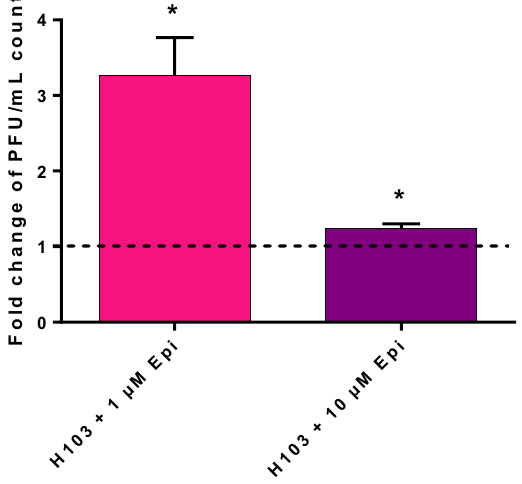
Figure 2. Effect of Epi on phage PO4 sensitivity. Phage PO4 sensitivity towards P. aeruginosa H103 was tested in presence of 1 and 10 µ M of Epi after 24 h. Plaque lysis were enumerated and expressed in PFU/mL, fold change is expressed for each condition. The error bars indicate the standard error of the mean (SEM). Two- tailed paired t -test was used (n = 4), * p = 0.025.